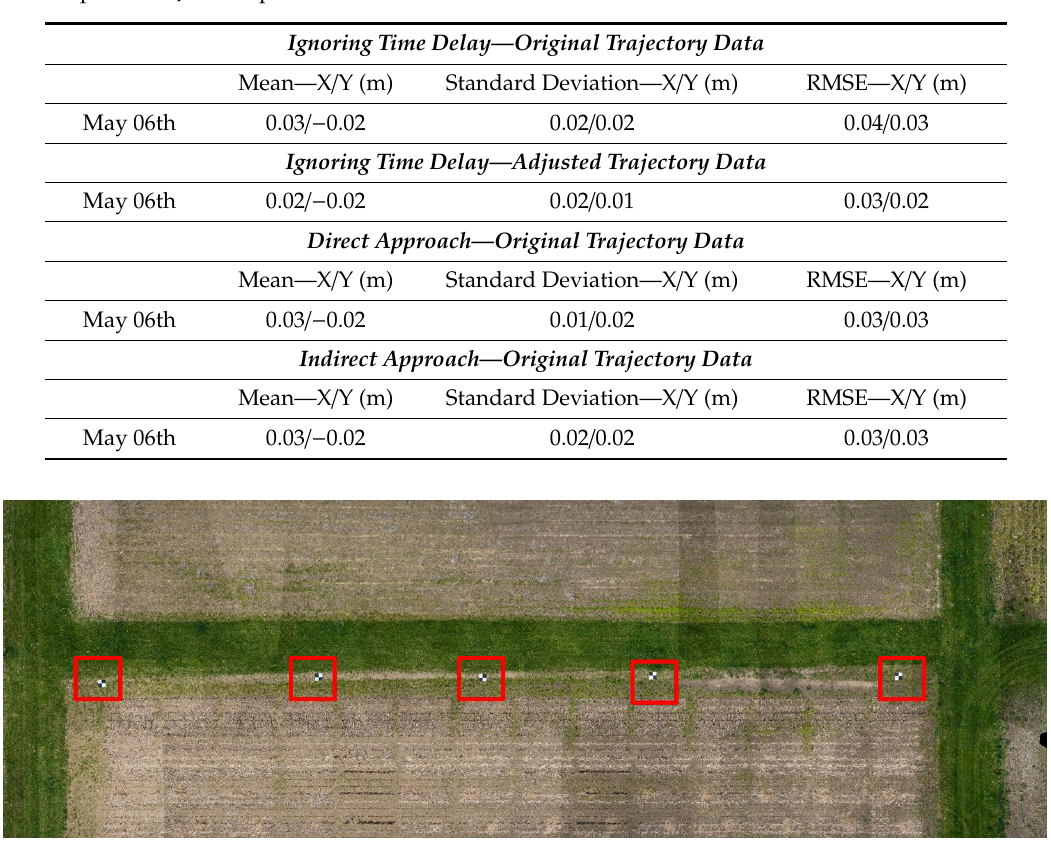
Table 16. Mean standard deviation of five check points from direct approach for the DJI M600 platform from bundle adjustment. Table 17. Derived statistics of horizontal / planimetric coordinates for five check targets derived from orthophoto—DJI M600 platform.